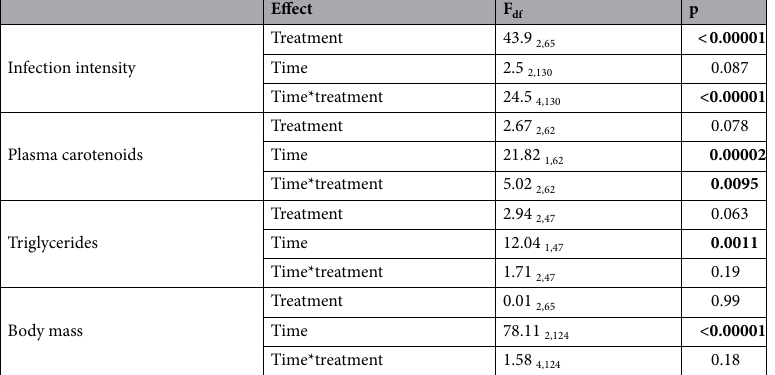
Table 1. Effects of treatment on infection intensity, plasma carotenoid, triglycerides and body mass. See Fig. 5 for the directions of the effects. Effects on infection intensity, body mass, and plasma triglycerides have been previously reported by R. Meitern and co-authors in 34 (https:// doi. org/ 10. 1002/ ece3. 2575, licensed under CC BY 4.0 https:// creat iveco mmons. org/ licen ses/ by/4.